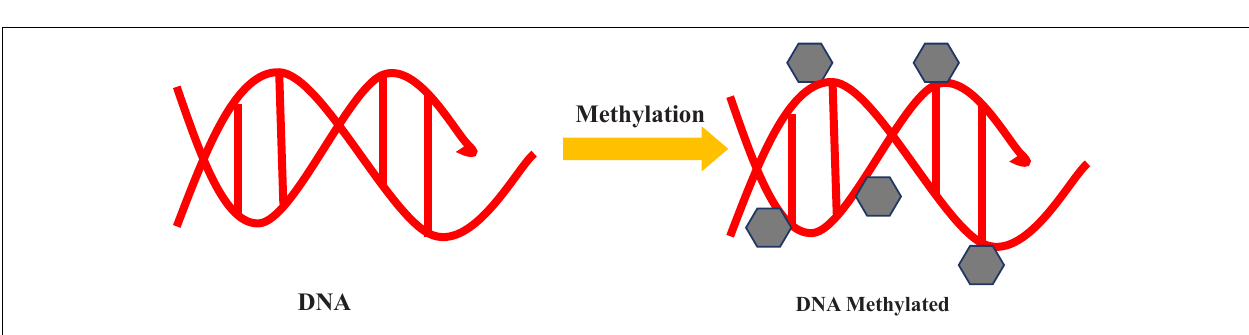
for methylation of cytosine 5 (cid:48) -carbon atom ( Figure 2 ).